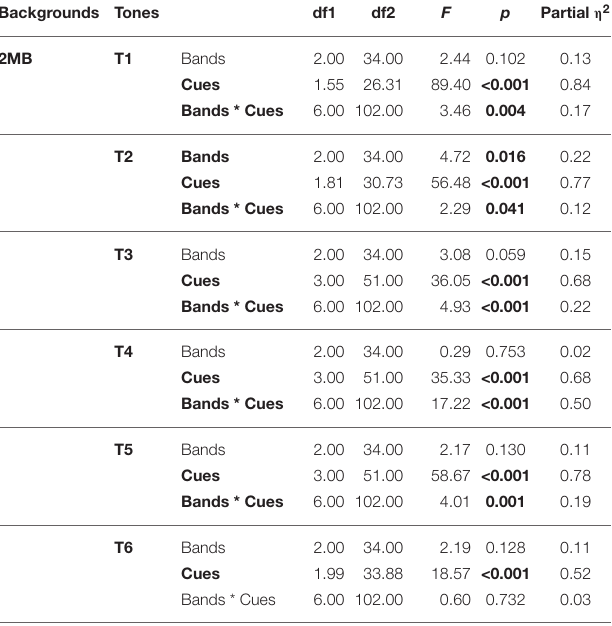
TABLE 5 | Results of Bands * Cues two-way repeated measures ANOVA on tone accuracy by Tones when Backgrounds = 2MB. Backgrounds